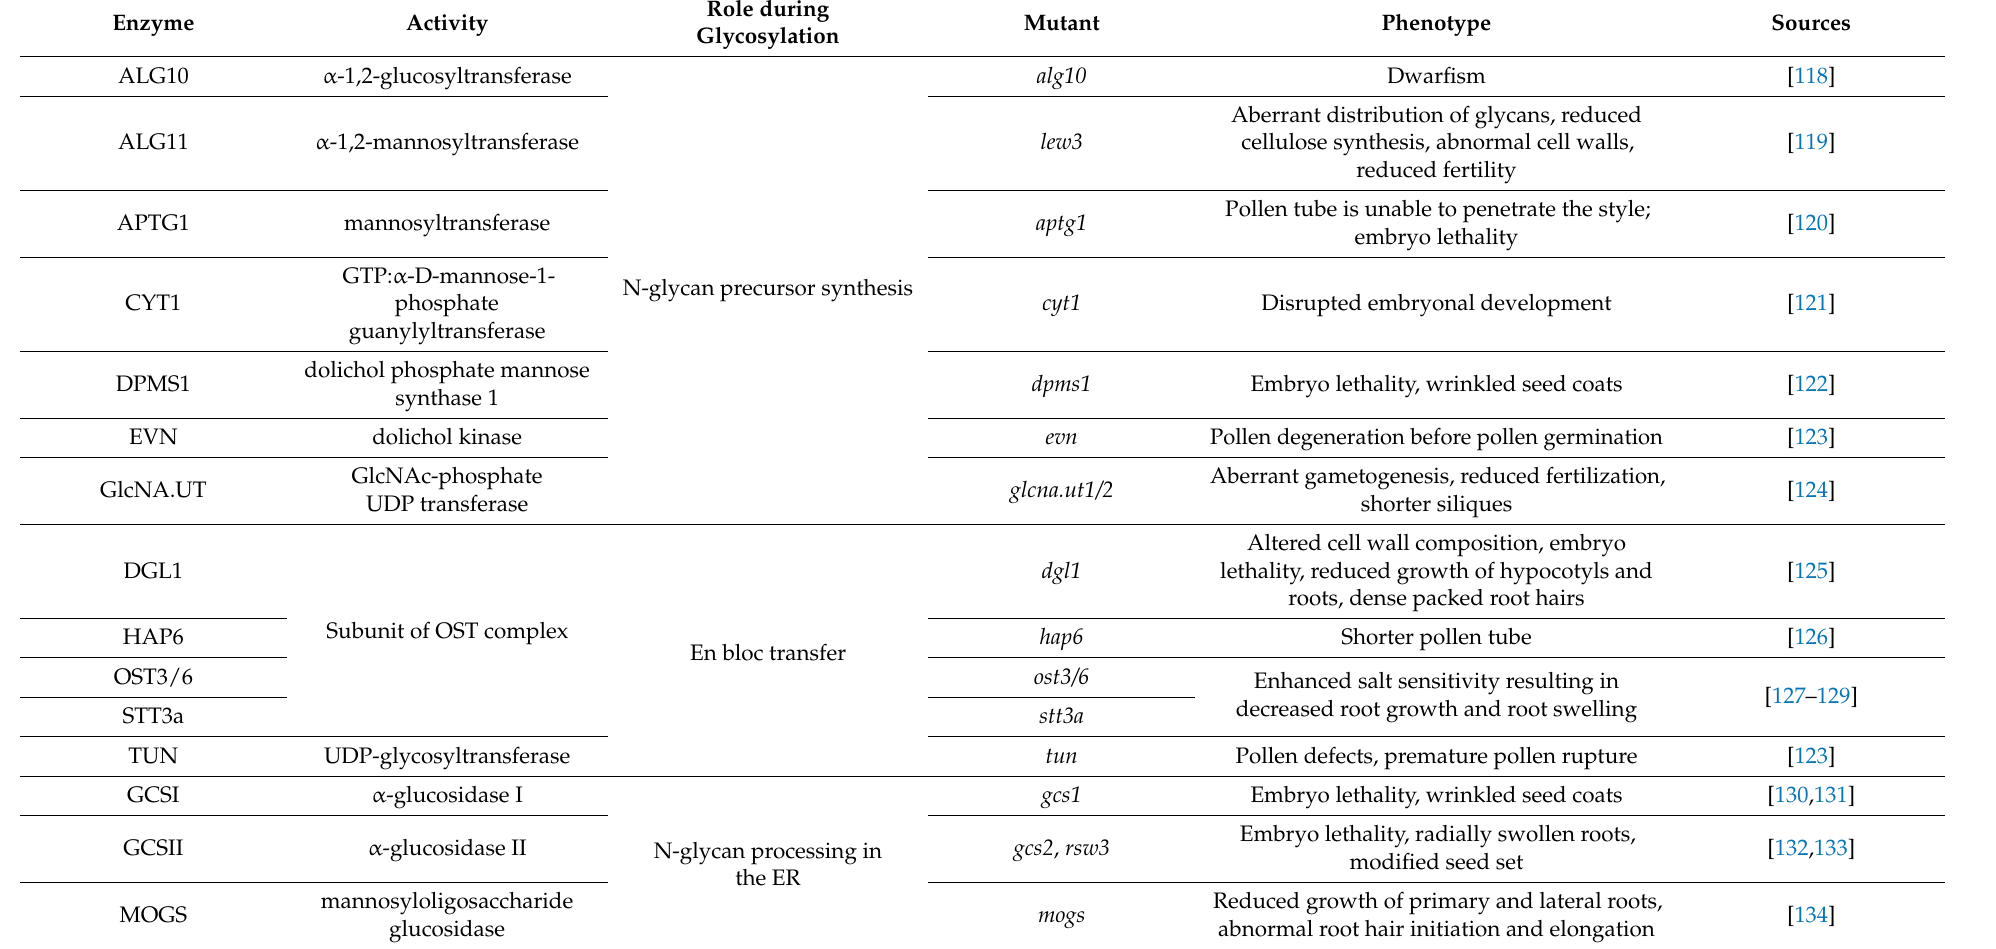
Table 1. Overview of N- and O-glycosylation-related enzymes whose mutants display relevant phenotypes for plant